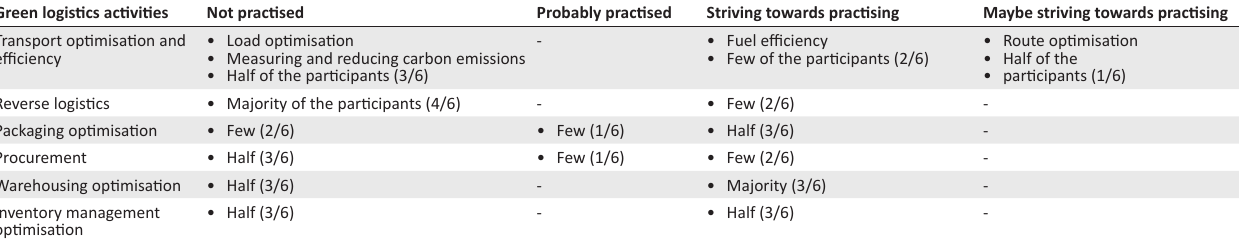
TABLE 4: Green logistics activities practised. Green logistics